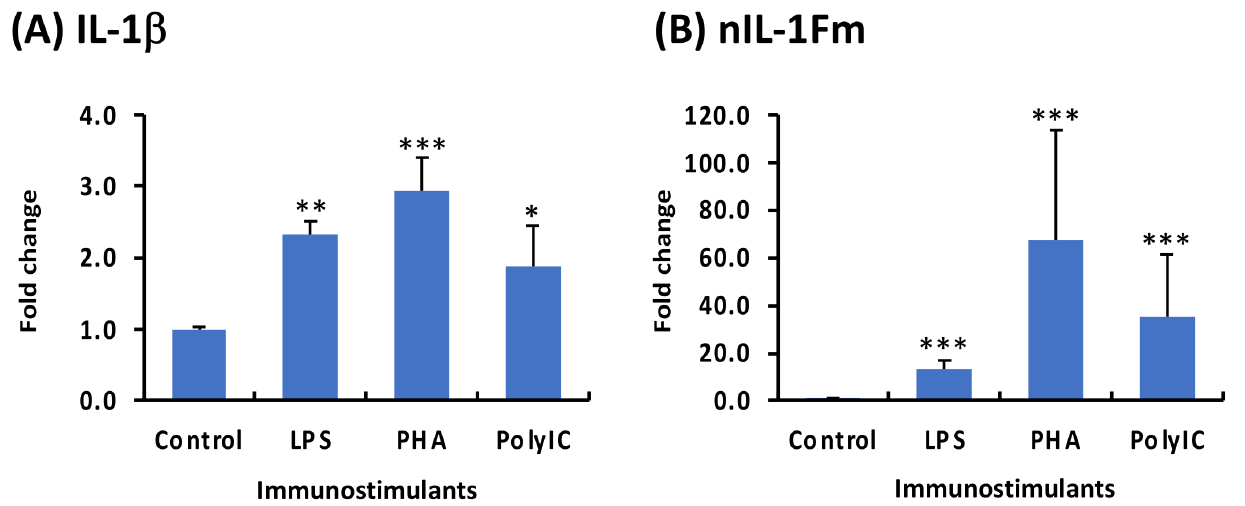
Figure 7. Modulation of IL-1 β ( A ) and nIL-1Fm ( B ) gene expression in the PBLs by LPS, PHA and poly (I:C). The cells were stimulated with different immunostimulants, and culture medium as a control. The expression was conducted by qRT-PCR. The fold change in comparison to the control was pre- sented as the expression levels were normalized by β -actin. The results are presented as mean + SEM. One-way analysis of variance was used to statistically compare the observed mRNA levels (* p < 0.05, ** p < 0.01, *** p < 0.001).